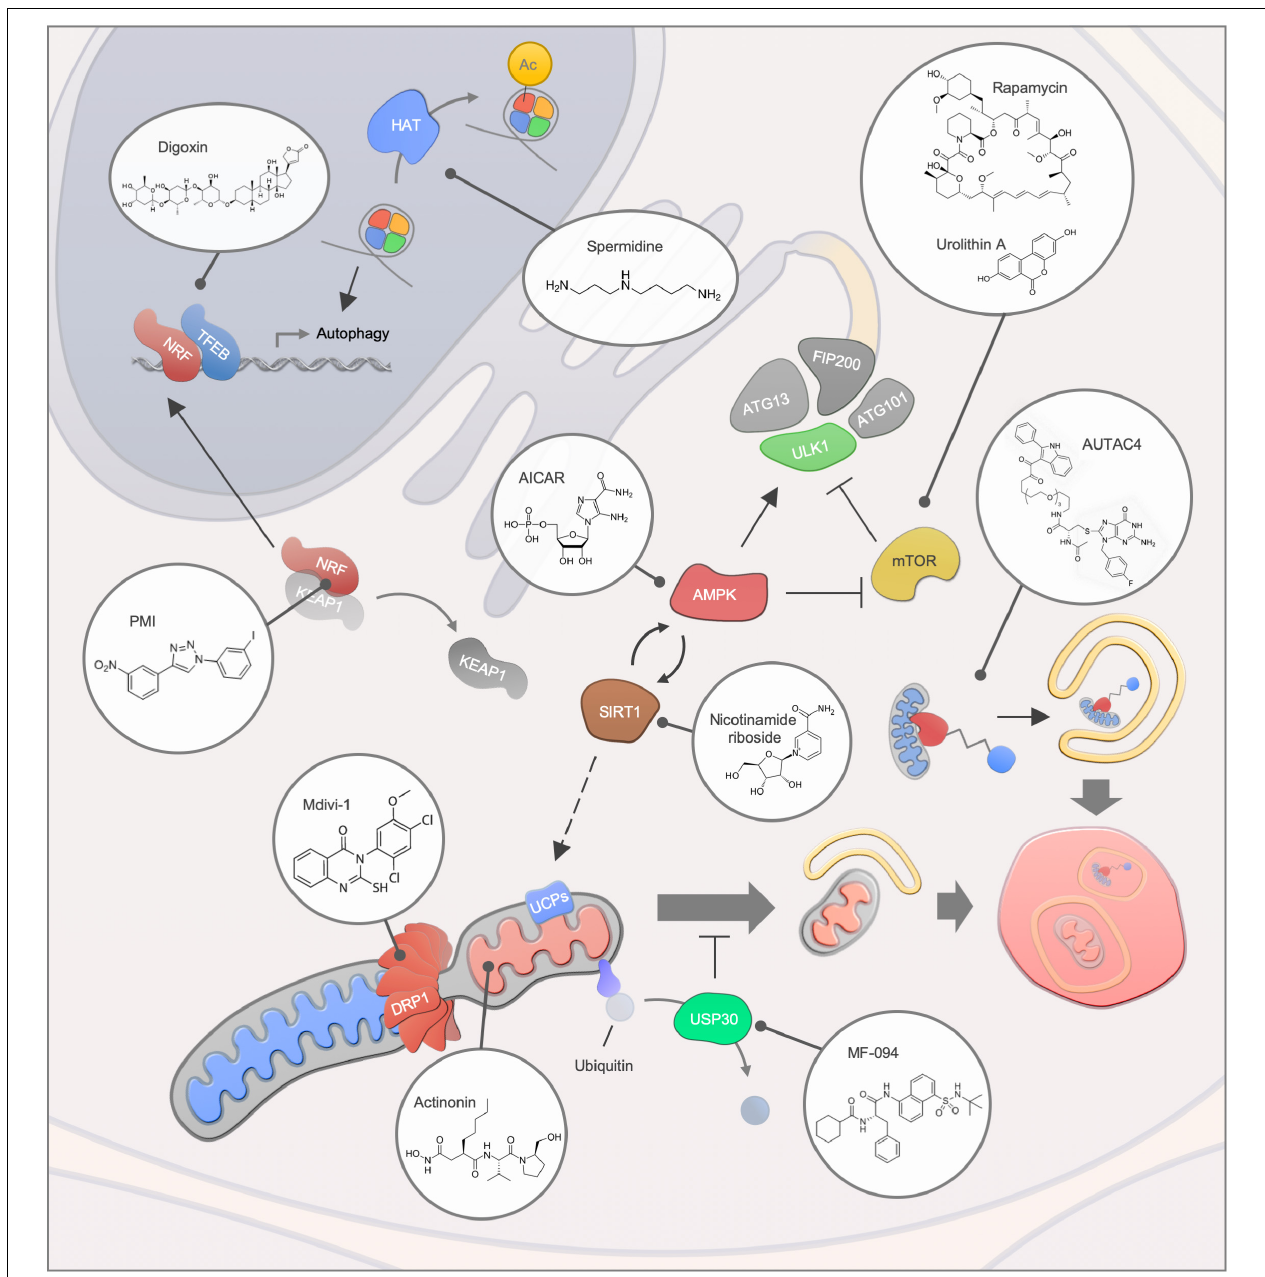
FIGURE 3 | Mitophagy interventions. An overview of different mitophagy modulating compounds and their targets. Abbreviations: Ac, Acetylation; HAT, Histone